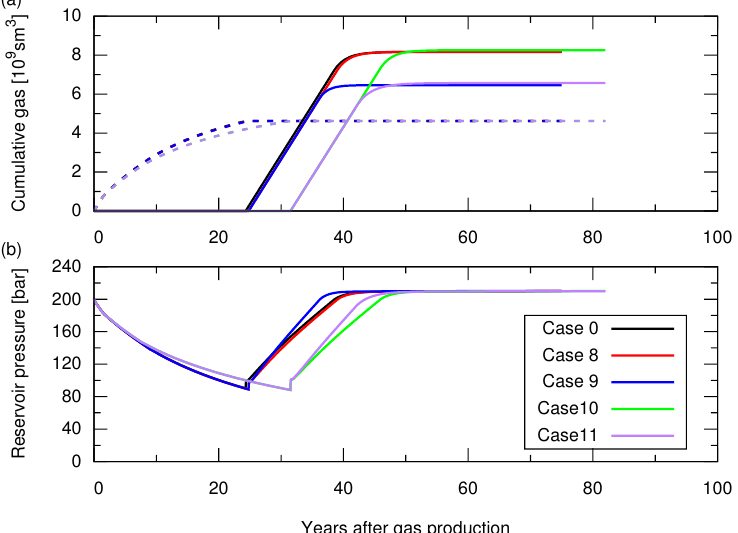
Figure A3. Simulation results of the CO 2 injection following the hydrocarbon gas production for cases 0 and 8 to 11; the influence of rock compaction and its reversibility was studied in Section 3.3 of the main text. See Table A1 for the descriptions of these cases. ( a ) Cumulative amount of the produced CH 4 in the dotted lines and cumulative amount of the injected CO 2 in the solid lines; ( b ) Average pressure at the datum depth of 2015 m as a function of